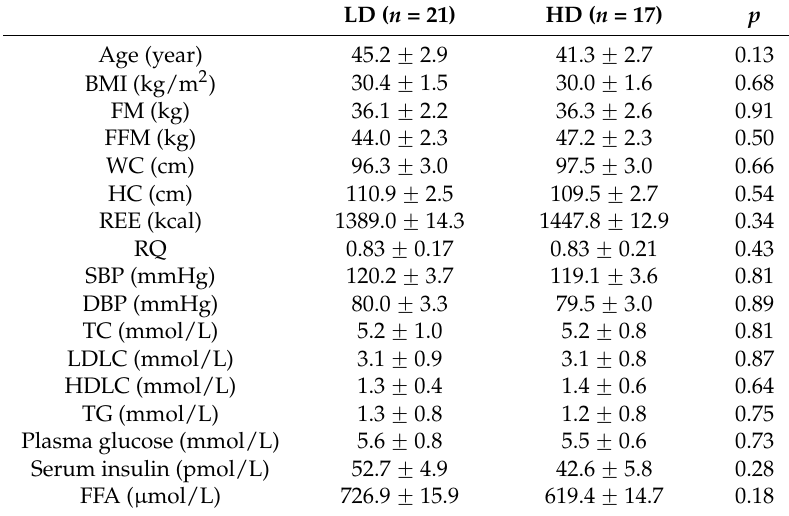
Table 1. Characteristics of the participants at baseline during energy-restricted intervention with high or low dairy products a .